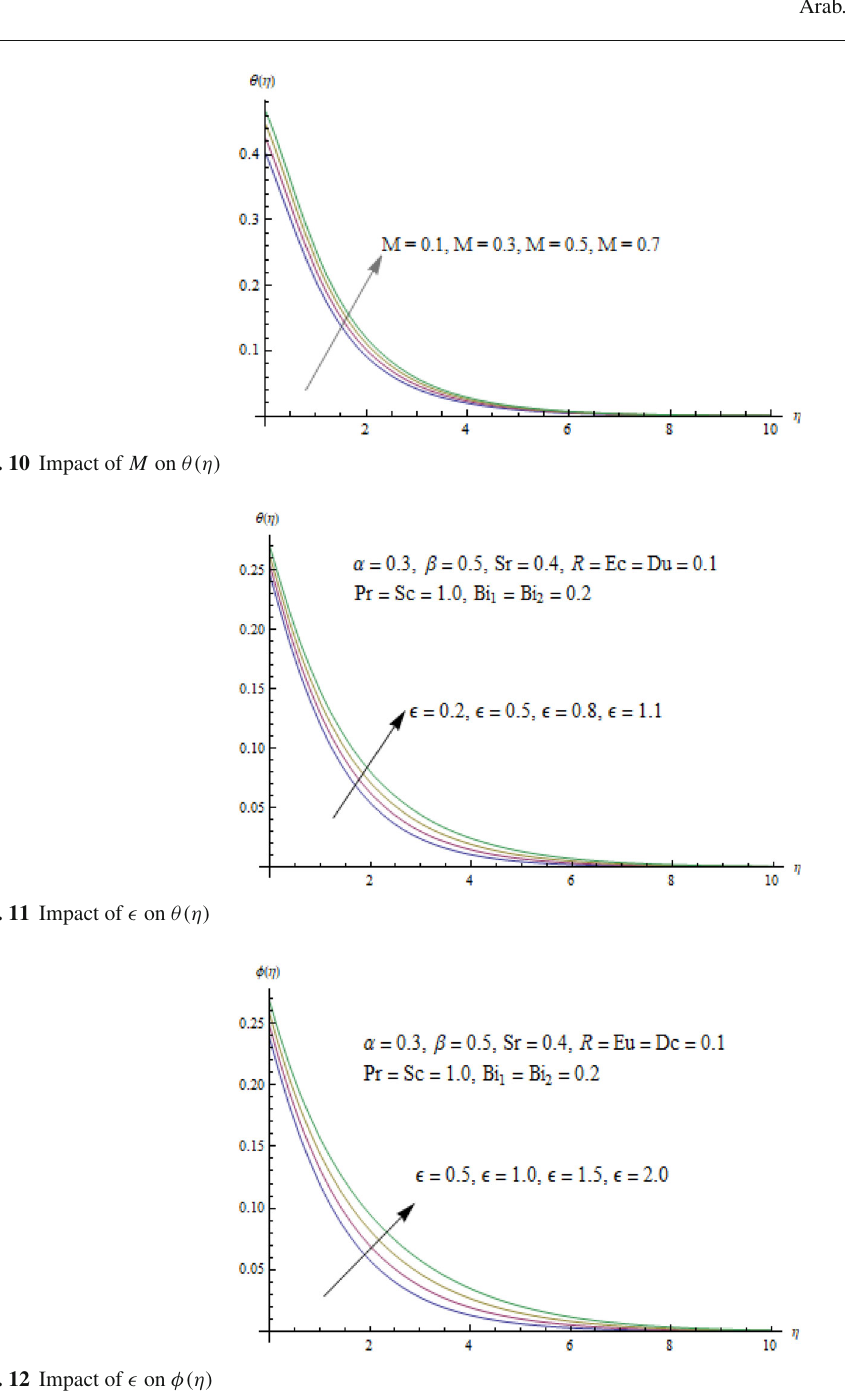
Fig. 12 Impact of (cid:2) on φ(η)